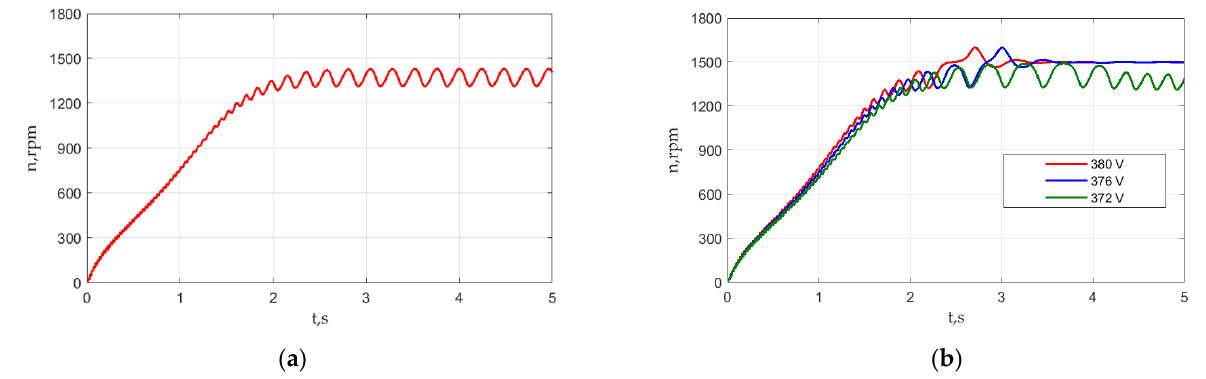
Figure 7. LSMPM rotational speed versus time: ( a ) Fully open valve, 380 V; ( b ) fully closed valve, various voltages.